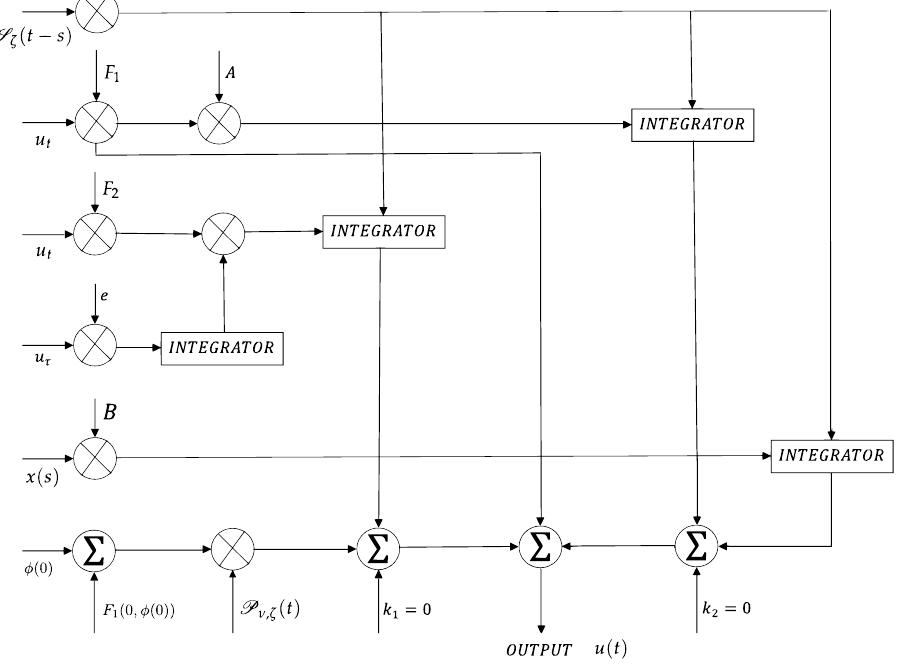
Figure 1. Filter